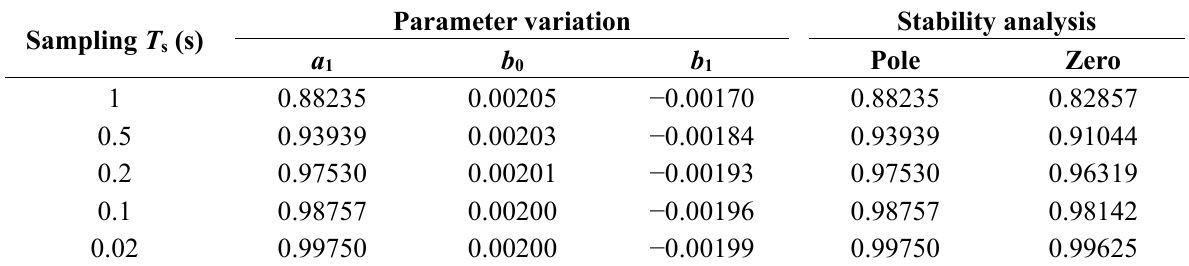
Table 3. Parameter variation and stability analysis for the auto regressive exogenous (ARX)